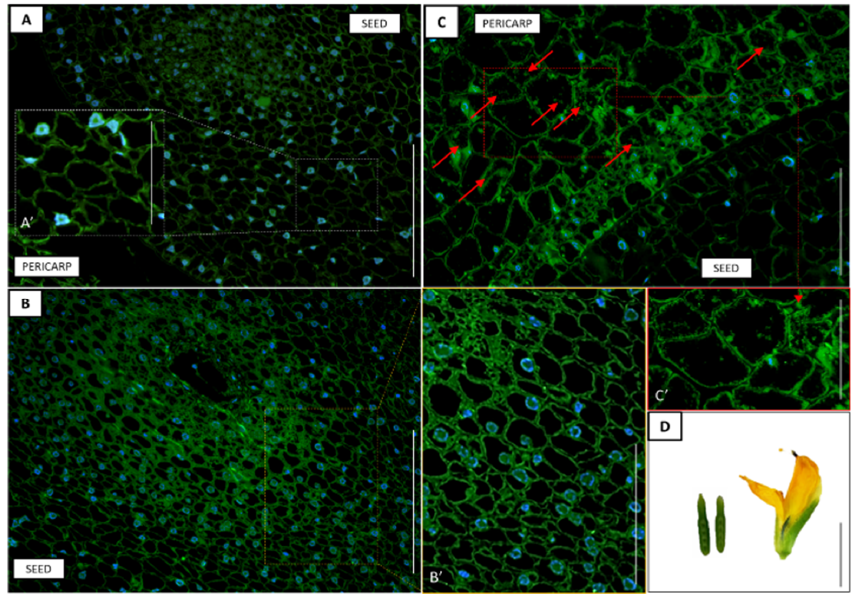
Figure 9. Tissue and cellular localization of gibberellic acid (GA 3 ) ( A – C ) in the early phase (10F; D ) of pericarp and seed development in yellow lupine. Moderately low but visible GA 3 level was observed in the pericarp ( C,C’ ). In seeds, the phytohormone molecules were undetectable ( A,A’,B,B’ ). The subfigures A', B' and C' are an enlargement of A, B and C, respectively. Red arrows indicate the localization of GA 3 . DAPI was used for nuclei staining. Scale bars: 100 µm (A,B), 50 µm (B’,C), 30 µm (C’), 25 µm (A’), 1 cm (D).